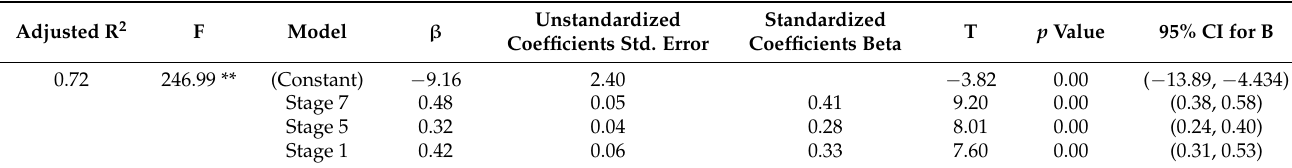
Table 3. The stepwise regression model in the first seven stages to predict ego integrity ( n = 292). Unstandardized Adjusted R 2 F Model β Coefficients Std.